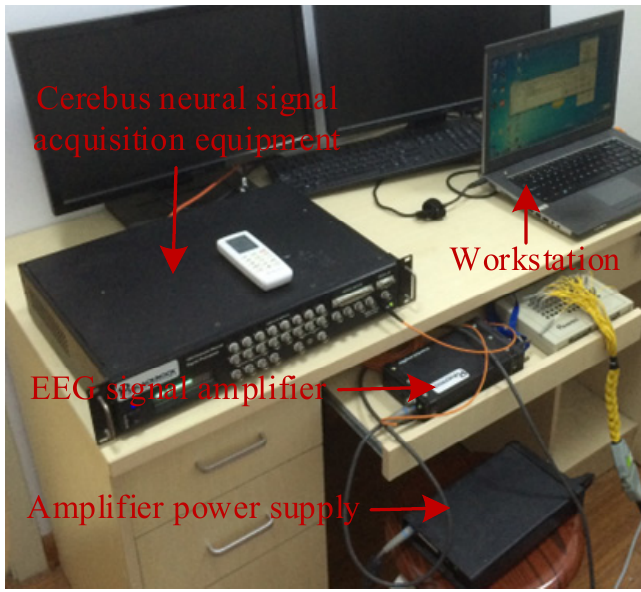
Figure 1. Experimental platform. The experimental platform consists of an amplifier power supply and a signal amplifier, Cerebus signal acquisition equipment, and